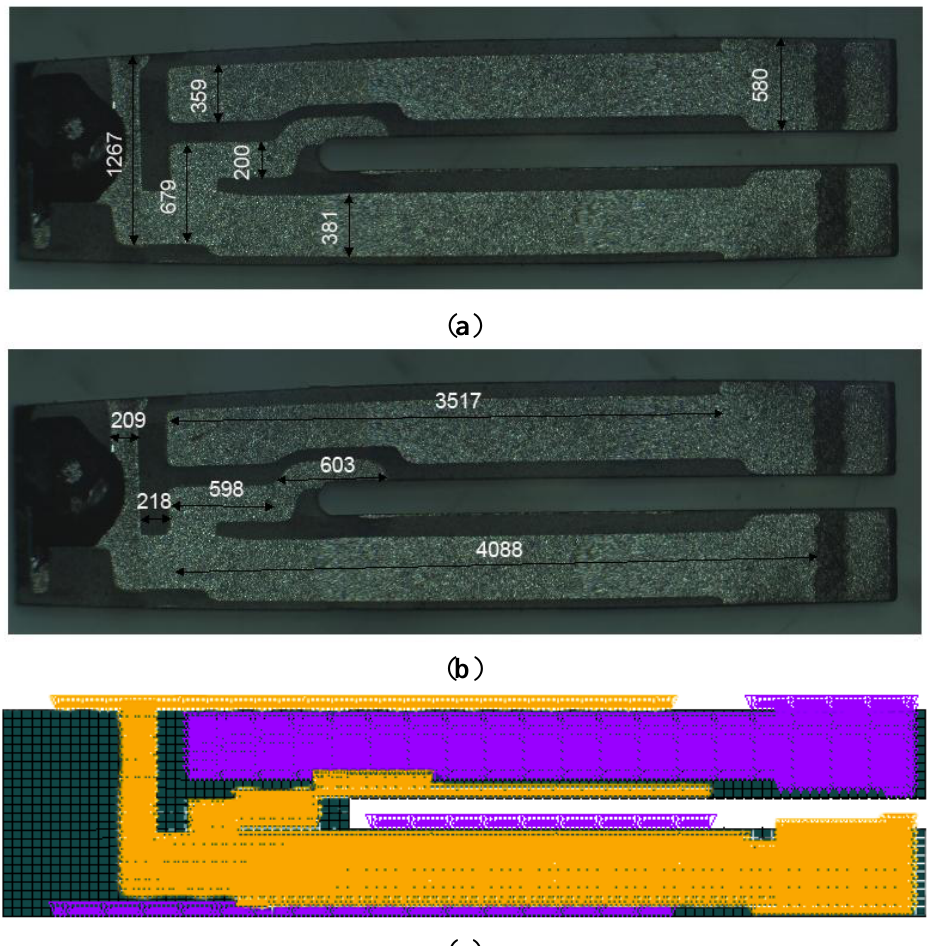
Figure 2. ( a and b ) Electrodes of the QTF are according to the optical microscope measurements. ( c ) The electrodes in ANSYS are defined at the bottom and top face of the QTF symmetrically. Dimensions are in 